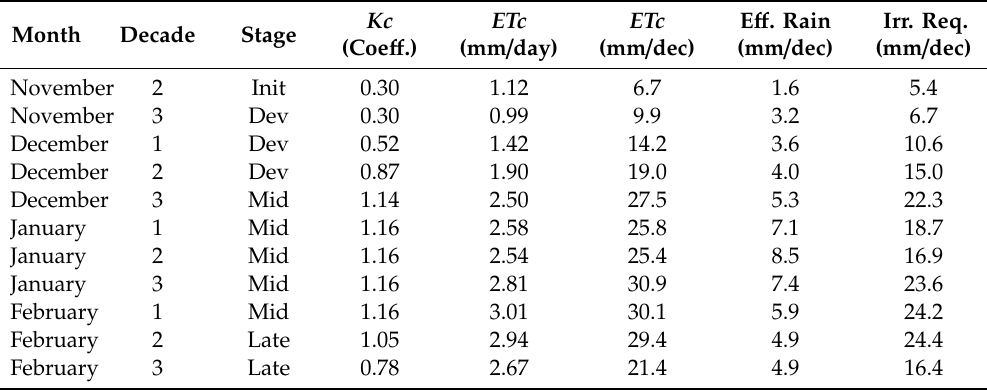
Table 4. Crop water requirement for